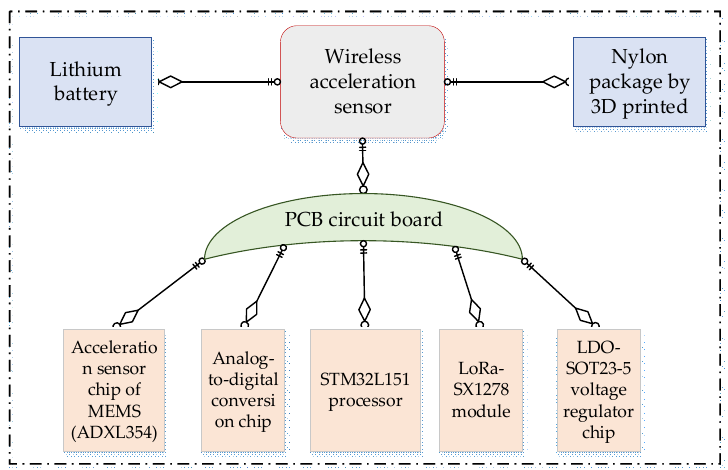
Figure 1. The composition of wireless acceleration sensor.